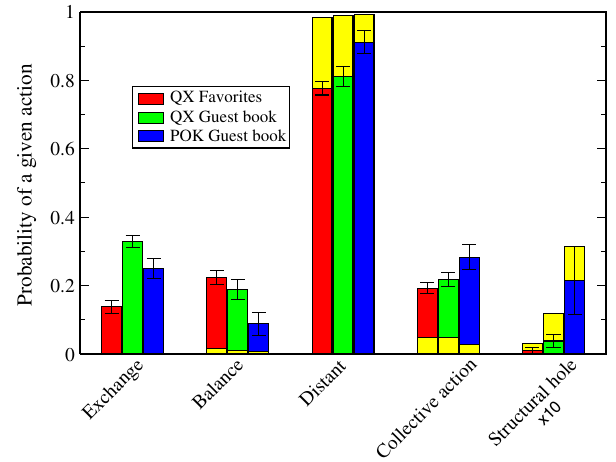
FIG. 2. The relative appearance of the five probabilistic tenden- cies in the actions of the community members in QX using favorites (red), in QX using guest book (green), and in POK using guest book (blue). These tendencies are compared to a completely random selection (yellow). Exchange and balance are practically nonexistent in random selections, but carry significant weight in the interactions of the real communities. Connecting to distant members appears in the community much less frequently than in random, while the preference towards well-connected agents (collective action) is significantly more prominent. Finally, the structural hole is significantly suppressed in the real communities compared to the randomized